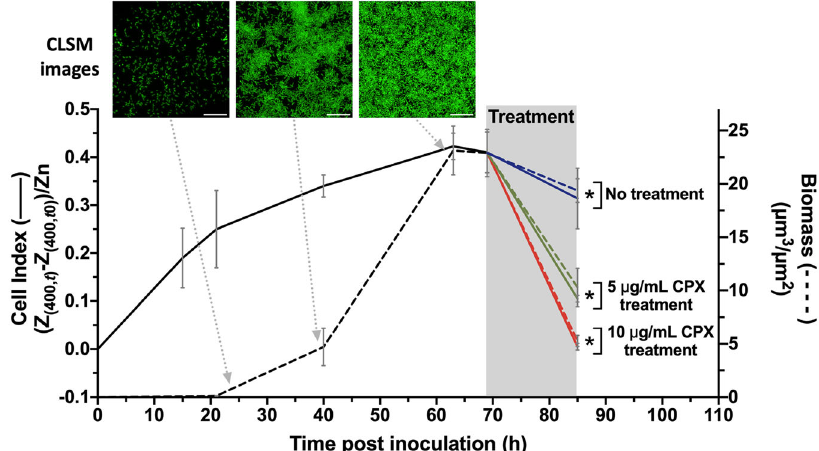
Fig. 5 Correlation in real time the bio fi lm formation and removal using confocal microscopy and impedance measurement. Monitored P. aeruginosa MK171 (expressing eGFP) bio fi lm growth and effect of antibiotic treatment evaluated on the basis of electrical impedance (represented as the CI, left y -axis, solid line) and biomass calculated from confocal microscopy images (de fi ned as μ m 3 / μ m 2 , right y -axis, dashed line). In the shaded part, corresponding to the treatment duration, green and red lines represent 5 μ g/ml and 10 μ g/ml cipro fl oxacin treatment, respectively, and the blue line illustrates the control without treatment. The values shown are the average of three independent experiments, and the error bars indicate the standard deviation between the experiments. Representative confocal images from three different time points are shown. Scale bar represents 20 μ m. * p < 0.05 in a Pearson ’ s correlation